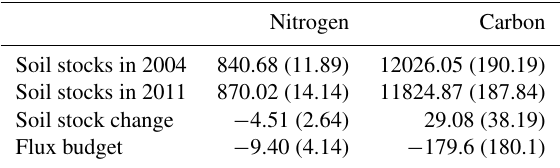
Table 6. N and C soil stocks (gN or Cm − 2 ) in May 2004 and May 2011 and budgets (gN or Cm − 2 a − 1 ) over 7 years based on re- peated soil N and C stock inventories and flux budget calculations (January 2004–December 2010). Soil stock changes are based on a soil mass of 800kgm − 2 , which corresponds to approximately 60cm depth. The flux budgets are averages for the years 2004– 2010 (Tables 4 and 5). Numbers in brackets represent confidence intervals. Negative numbers are